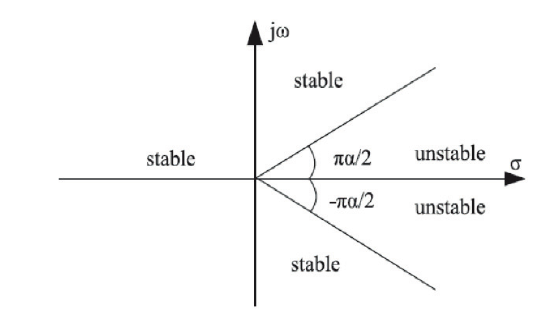
Fig. 2. Stability region of the fractional order